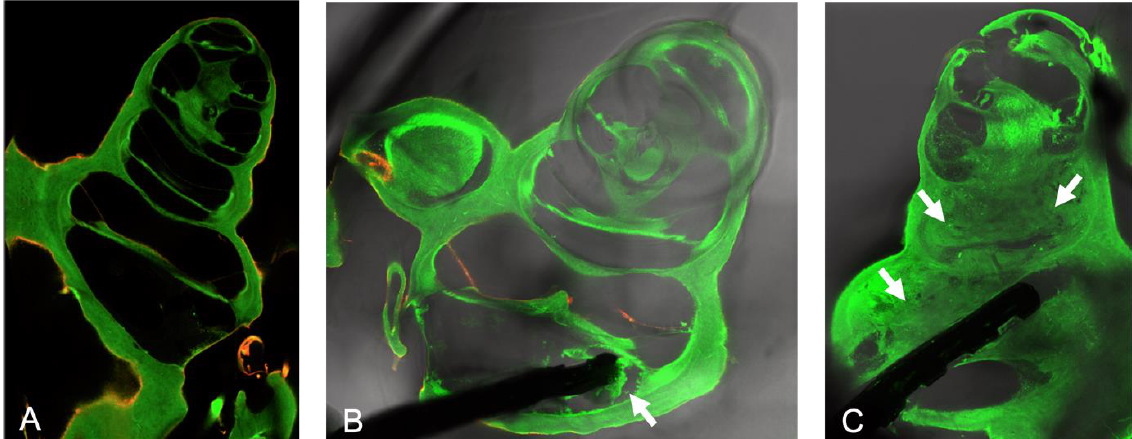
Figure 5. ( A ) Cochlea without implant, no connective tissue (Control group); ( B ) Cochlea with implant in the basal turn, connective tissue growth around the tip of the electrode (Control group); ( C ) Cochlea filled with connective tissue and damage caused by a coated electrode. The scala tympani of the lower basal turn is nearly free of tissue (MM284 group). Arrows = connective tissue.